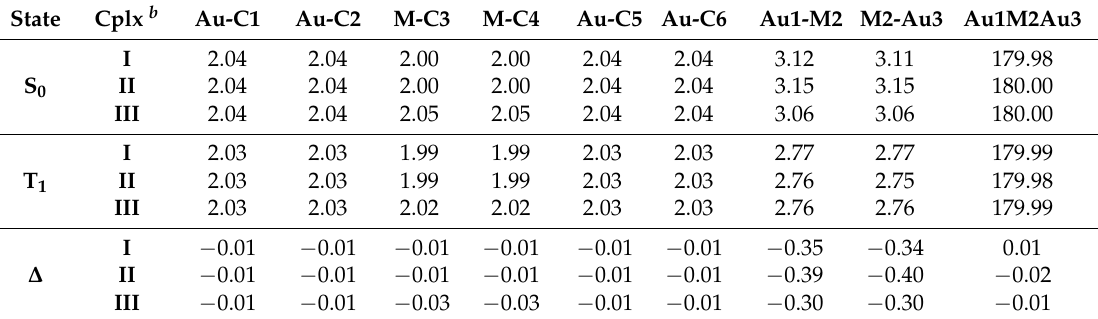
Table 4. Selected optimized parameters for I – III (bond length: Å, bond angle: ◦ .)